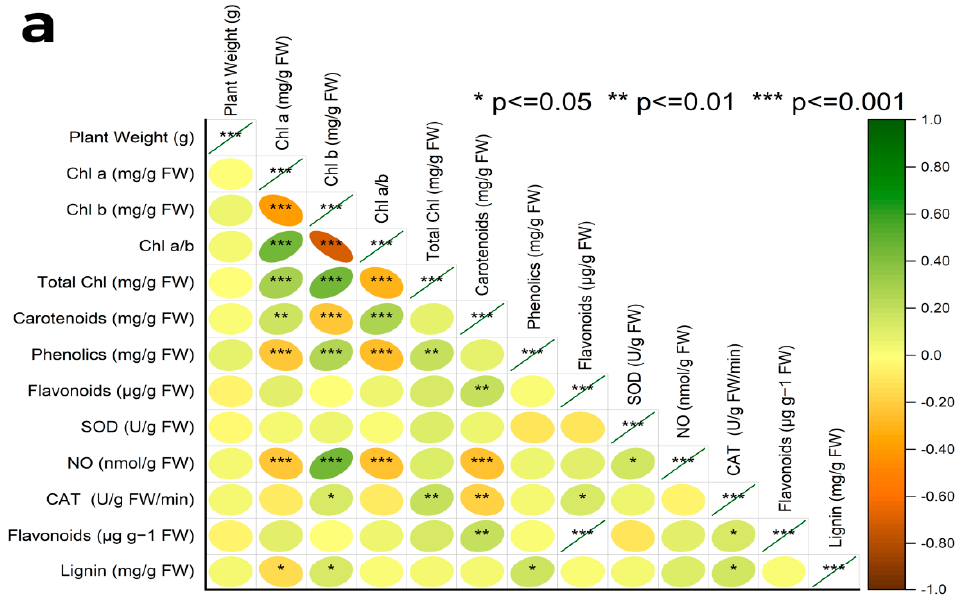
Figure 5. ( a ) Pearson correlation for different phytochemical analysesof Silybum marianum in hydro- ponics culture with different treatments where (T0 = control, T1 = methyl jasmonate, T2 = silver nanoparticles, T3 = fungal elicitors, T4 = methyl jasmonate + fungal elicitors, T5 = methyl jasmonate + silver nanoparticles, T6 = fungal elicitors + silver nanoparticles, T7 = methyl jasmonate + silver nanoparticles + fungal elicitors). ( b ) Principal component analysis of the effect of various treatments application in hydroponics culture to enhance phytochemicals of Silybum marianum . 3. Discussion It has been a long-standing practice to treat patients using medicinal plants to treat a variety of ailments. Plant small molecules such as photosynthetic pigments and carote- noids play a key role in photosynthesis. The elicitation technique has commonly been used to increase the production of plants’ important bioactive compounds in parts of plant cells with special reference to medicinal plants [47]. In the present study, different types of elicitors (abiotic and biotic) have been used to enhance the production of these valuable compounds by S. marianum [48,49]. The most commonly used and effective elicitors for the stimulation of secondary metabolite production are methyl jasmonate (MeJA), fungal cells, and metallic nanoparticles [50,51]. Moreover, among different culture systems, sci- entists and growers claim that hydroponic systems allow plants to increase their